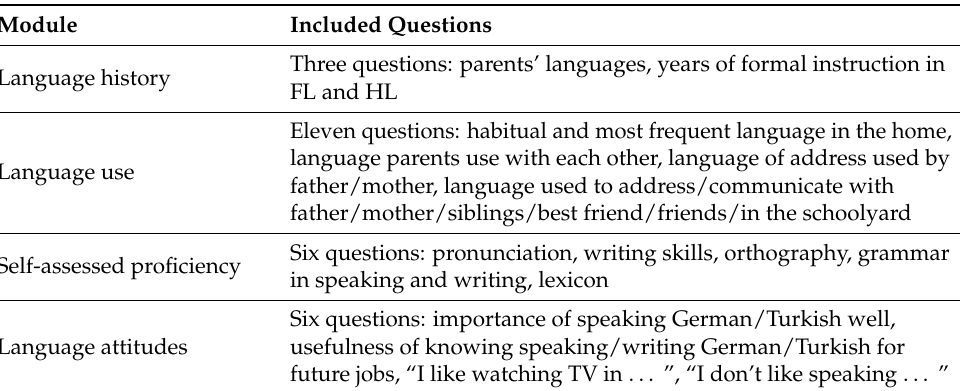
Table 3. Modules and questions included in the calculation of the dominance